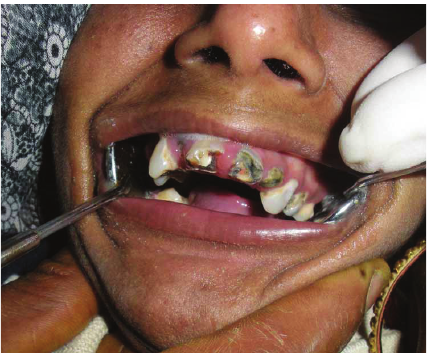
Figure 4: It shows the present dental